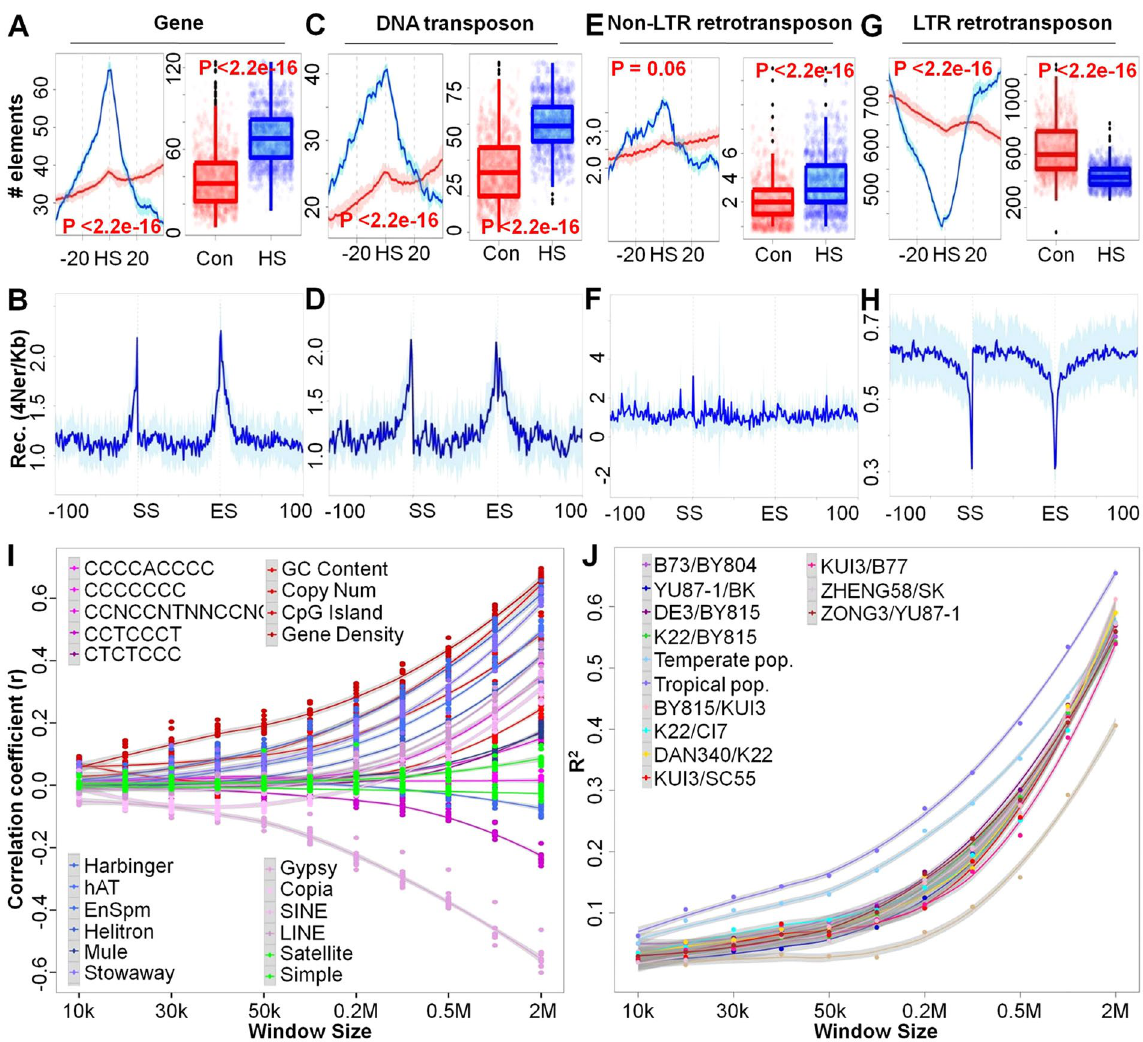
Figure 3. Relationships between recombination rate and local genomic features in maize. ( A , C , E , G ) Distribution of different genome components around recombination hot regions in segregating populations. “HS” is the short name of hot regions, while “Con” shows the random samples used as control. “ − 20” and “20” represent 20 Mb upstream and downstream genomic regions of hot regions. Blue and red represent recombination hot regions and control samples, respectively. ( B , D , F , H ) Recombination rate (4Ner/Kb) in 1 Kb bins spanning the 100 Kb upstream and downstream regions of different genome components in the natural temperate population from the Hapmap2 dataset. SS and ES indicate the start site and end site of genome content, respectively. ( I ) Correlation coefficients over 11 different sliding window sizes between 21 different genome components and recombination rate in 11 segregation populations. ( J ) The linear regression determination coefficient of genomic components in different window size relative to recombination variation in 11 segregation populations, and in temperate and tropical sub-populations of natural